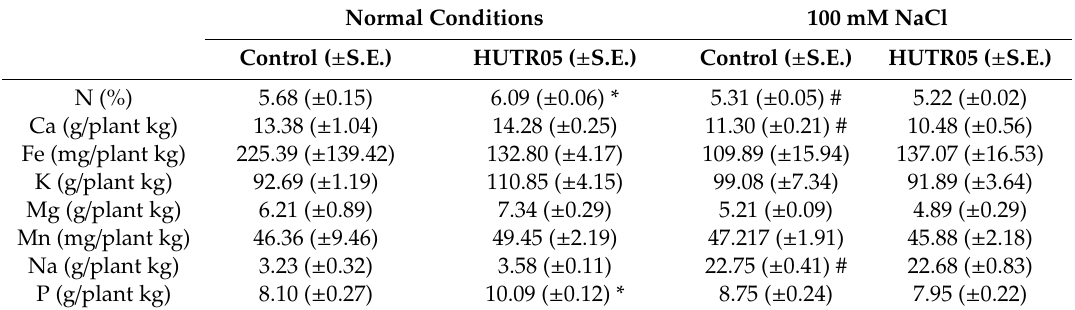
Table 2. E ff ects of Rhizobium laguerreae HUTR05 inoculation on nutrient contents of lettuce plants. Normal